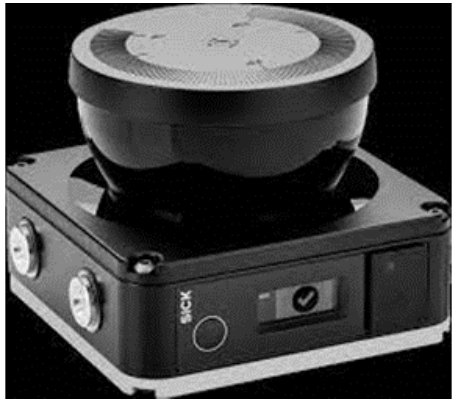
Figure 5. NANS3-CAAZ30AN1 safety laser scanner.